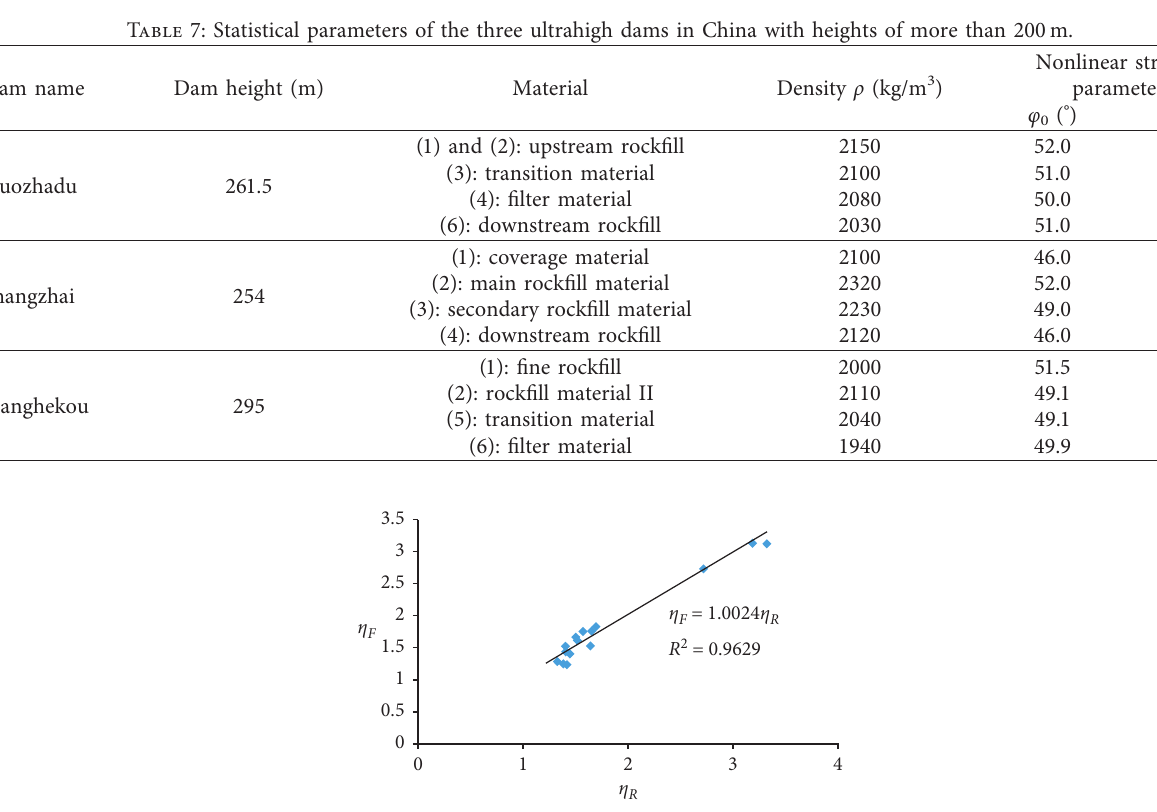
− η R F of the slope of the Shangzhai hydropower station.